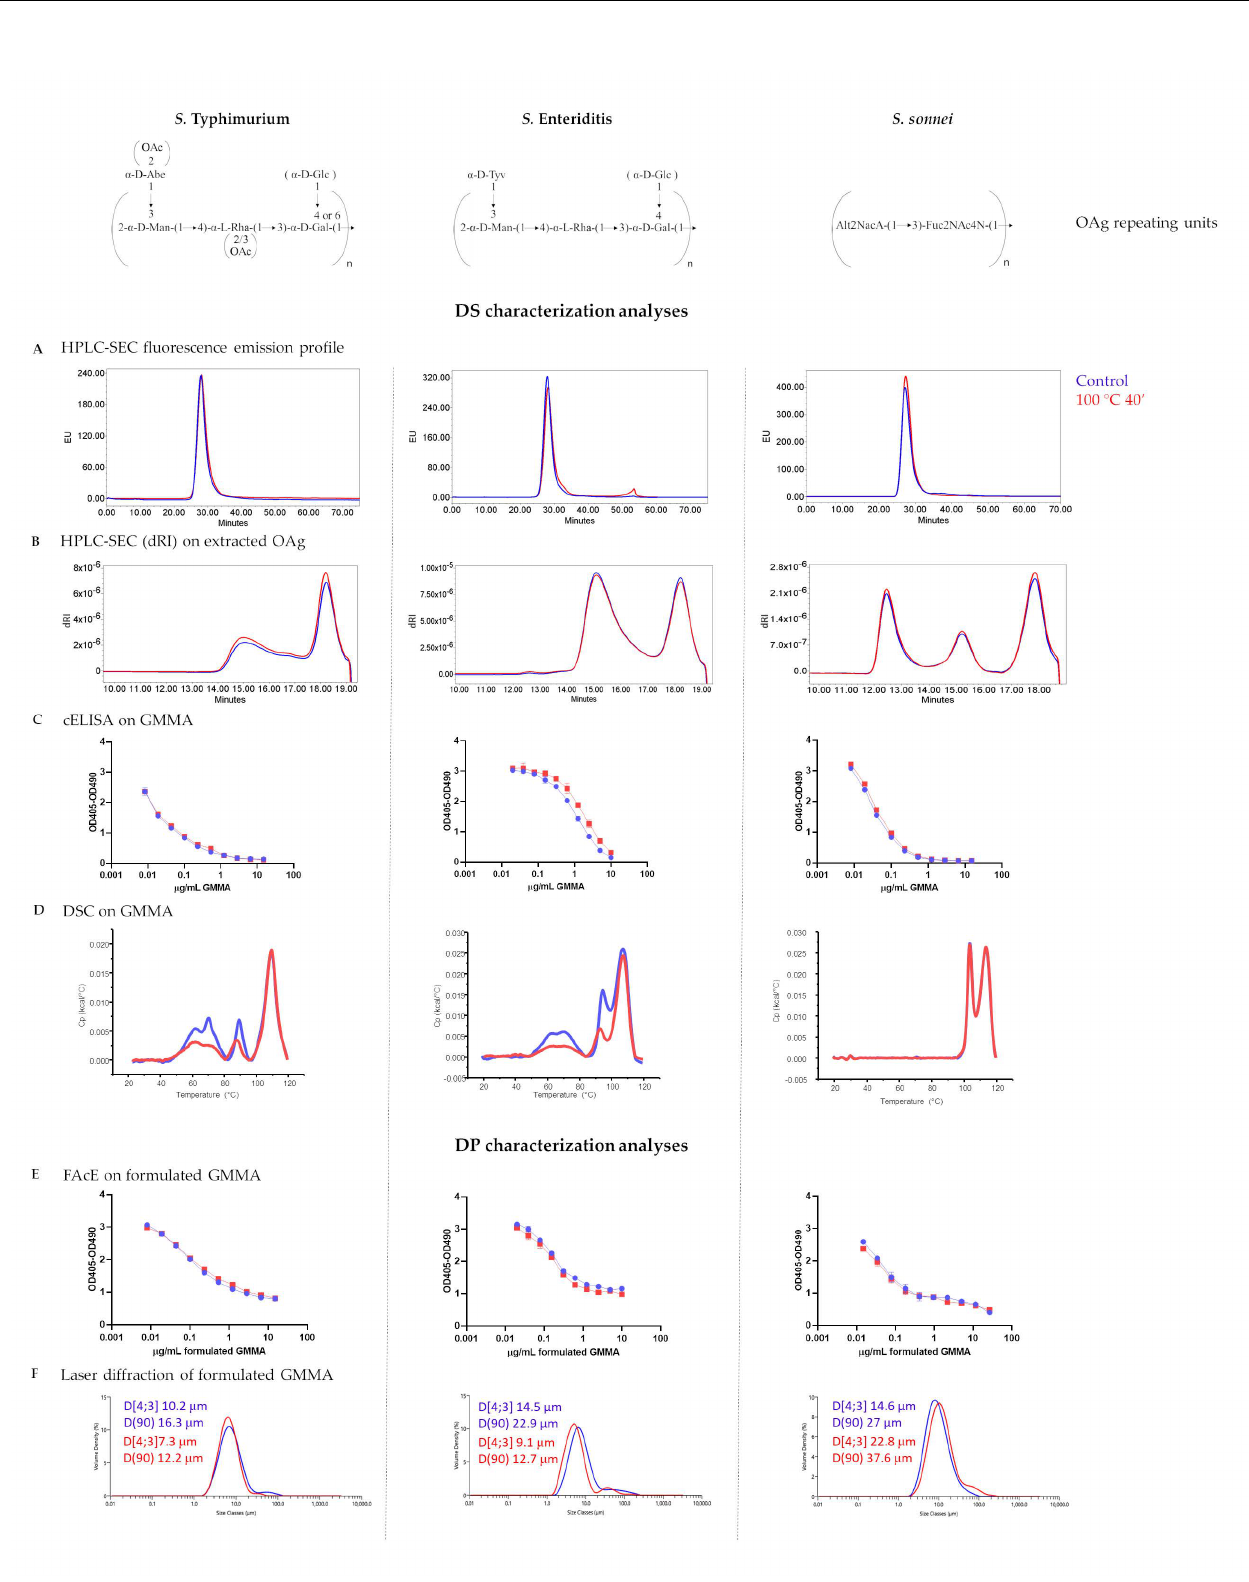
Figure 1. Stability of S . Typhimurium, S . Enteriditis and S. sonnei GMMA, both drug substance ( A – D ) and drug product ( E , F ), under very harsh conditions (100 °C for 40 min). No change in HPLC-SEC fluorescence emission profiles of stressed GMMA ( A ) and in OAg size populations distribution ( B ). No differences in anti-OAg specific mAb recognition for all three different types of GMMA, both drug substance ( C ) and drug product ( E ). Evidence of protein denaturation occurring in iNTS GMMA ( D ). No changes detected in terms of particle size ( F ) when GMMA were stressed after formulation on Alhydrogel. Blu lines refer to control GMMA, red lines to stressed GMMA.